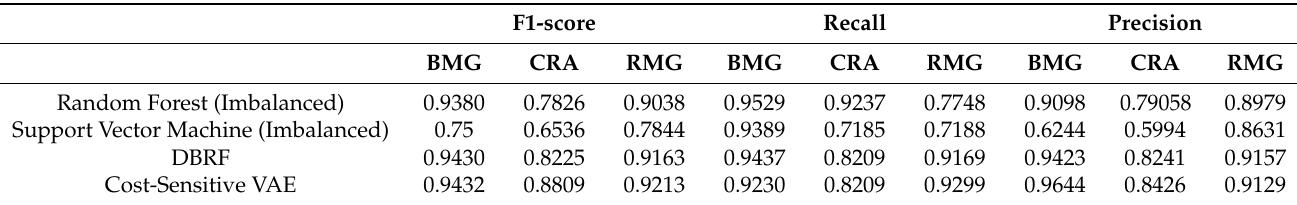
Table 4. F1-score, Recall, and Precision of different algorithms. F1-score Recall